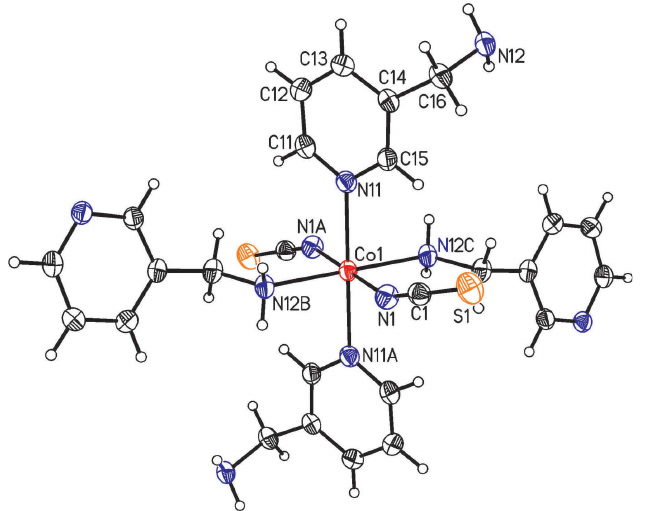
(cid:3) x , (cid:3) 1 (cid:3) y , 1 (cid:3) z , C = (cid:3) 1 (cid:3) y , (cid:3) 1 + x , 3 + z . Color code: 2 2 2 2 2 2